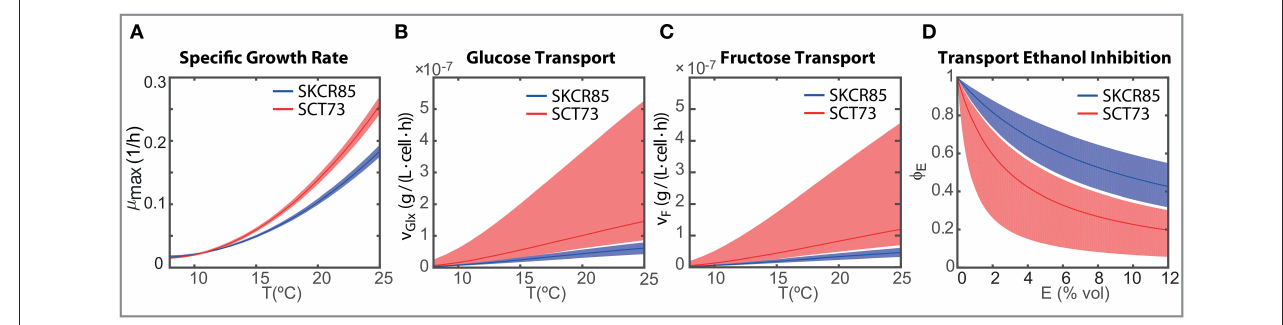
FIGURE 5 | Strain dependent ensemble predictions for (A) maximum specific growth rate depending on the temperature; (B) temperature dependent glucose transport per cell for initial concentration 100 g/L glucose and 0 g/L ethanol; (C) temperature dependent fructose transport per cell for initial concentration 100g/L fructose and 0g/L ethanol; (D) inhibitory effect of ethanol on the transport of glucose and fructose.